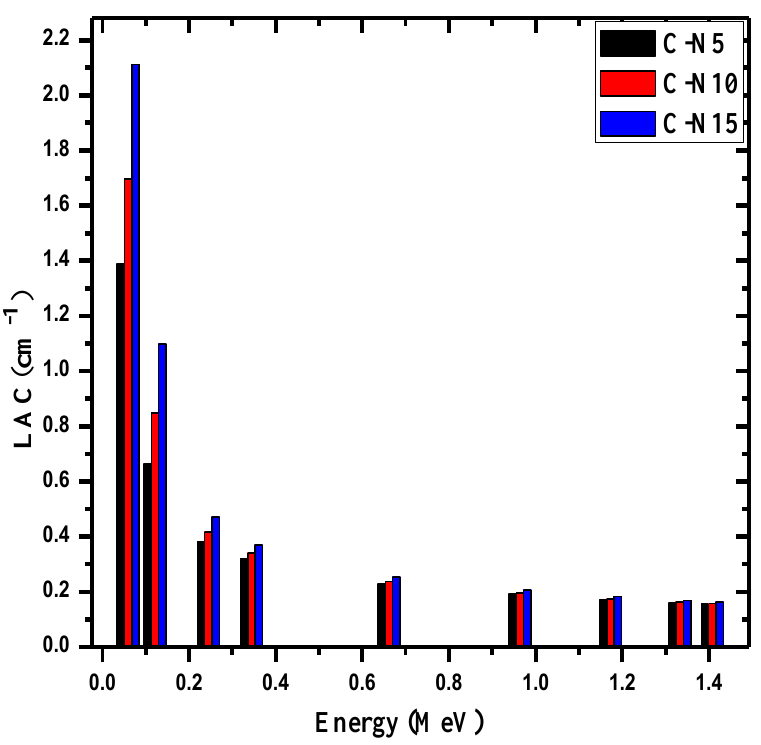
Figure 5. The linear attenuation coefficient for the C-N5, C-N10 and C-N15. The half-value layer (HVL) is an important radiation shielding parameter [36 – 39].